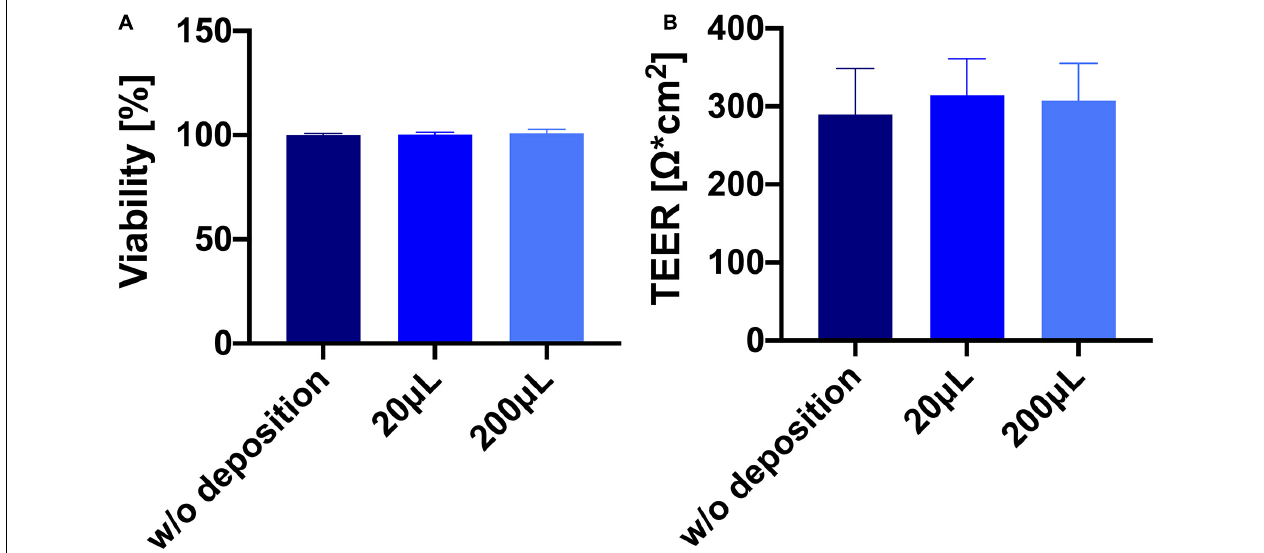
FIGURE 7 | Deposition of phosphate-buffered saline (PBS) on Calu-3 cells grown in Transwell R (cid:13) inserts is well tolerated. (A) Viability of Calu-3 cells [Lactate dehydrogenase (LDH), see section “Materials and Methods”] 24 h after deposition of PBS. (B) Barrier properties of Calu-3 cells 24 h after deposition. N = 9 of three individual experiments. No significant difference was found between the groups ( p >